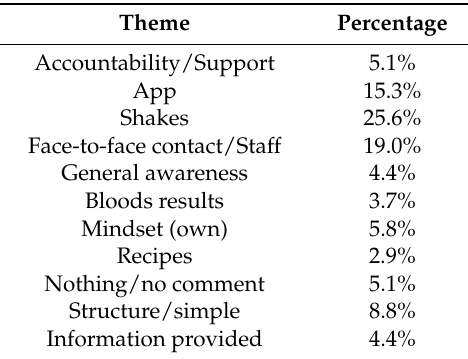
Table 3. Percentage of different themes of open-ended responses about most helpful aspect of the program received at week 12 of the